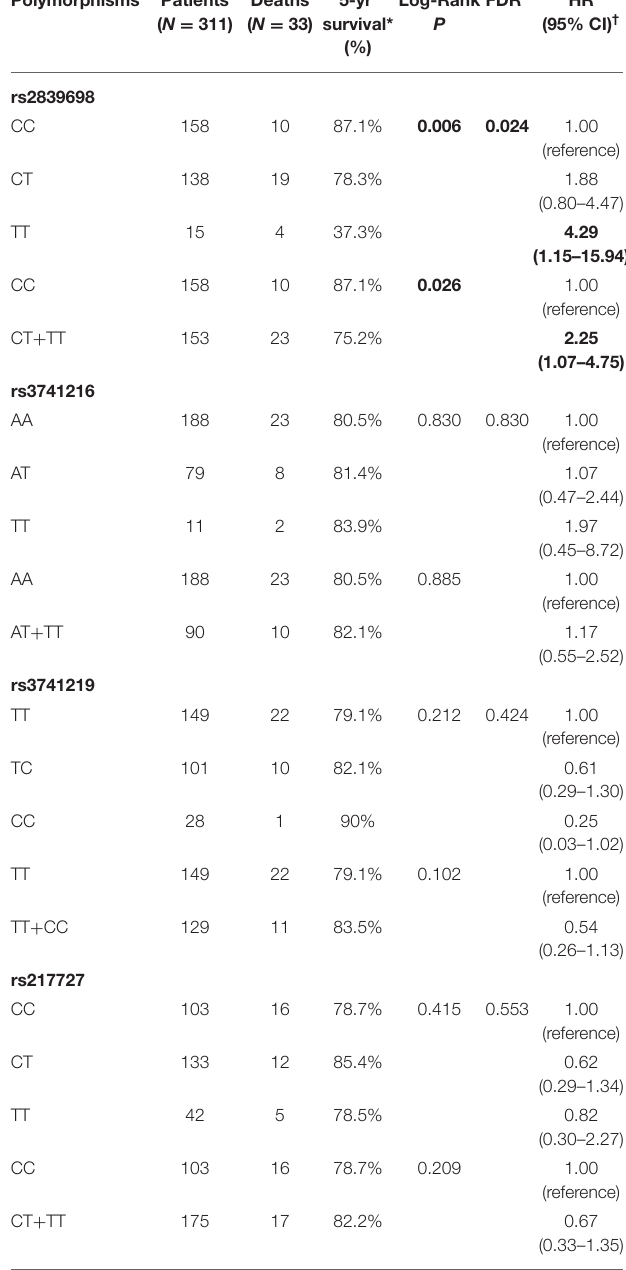
TABLE 3 | Associations of H19 polymorphisms with RCC patients’